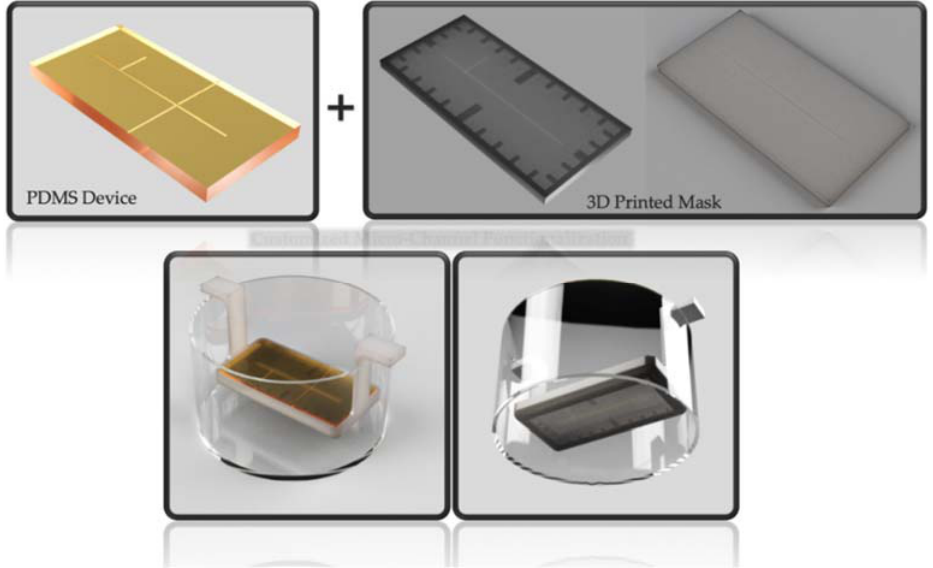
Figure 2. Rendering of the mask–device assembly suspended by a 3D printed support in the bath to grow ZnO inside the device’s channel.